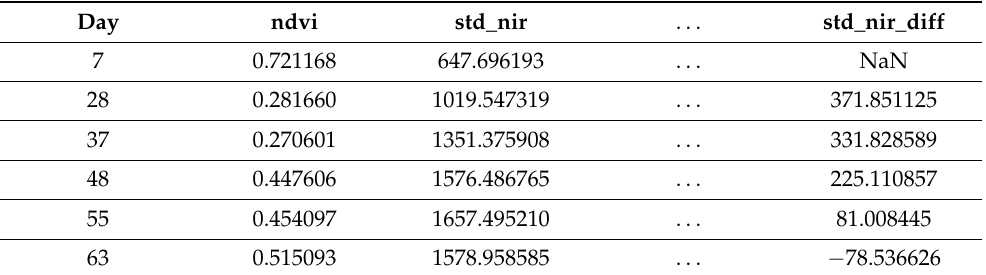
Table 8. Growth stage prediction results of cabbage from Day 0 to Day 70.